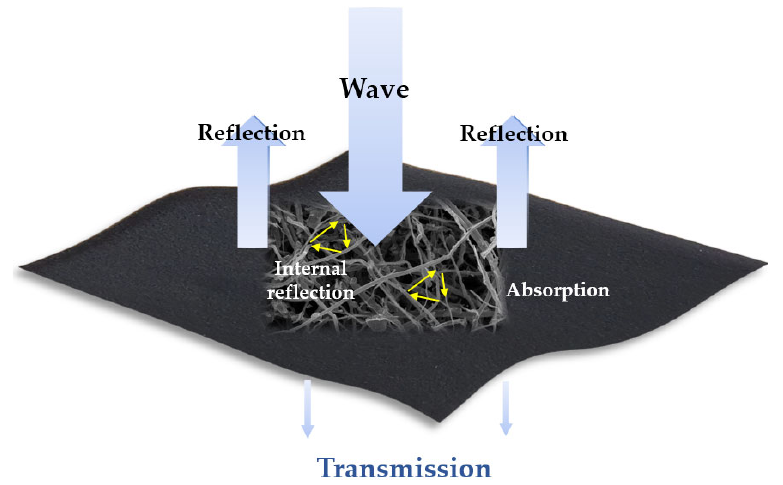
Figure 2. Electromagnetic interference shielding mechanism of the TGCF/CNT carbon paper.